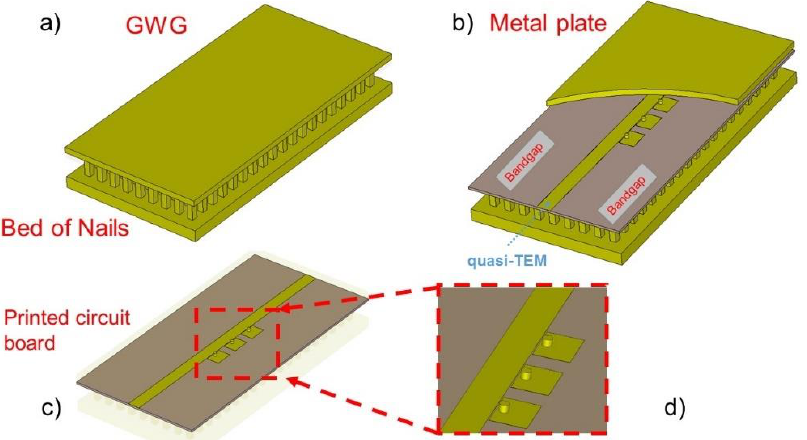
Figure 9. Proposed inverted microstrip gap waveguide configuration for the filter with the truncated EBG structure (3-cells): ( a ) View of the parallel plate gap waveguide ( b ) Multilayer configura- tion for the proposed inverted microstrip ( c ) Printed circuit board with the filter ( d ) Detail of the EBG resonators.